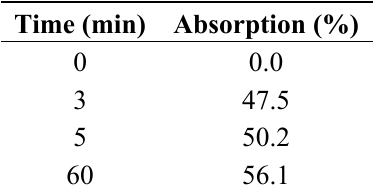
Table 4. Percentage of water absorption during the first hour of soaking.